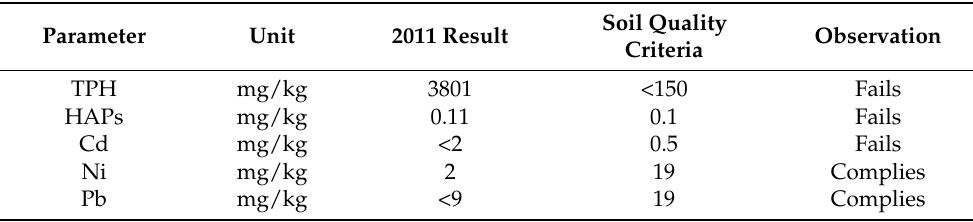
Table 8. Results of the physical-chemical analysis of the Tiputini area. The first results are from EIA and PMA (code B1) and soil quality criteria are from AM097 -A (Table 1) [103], based on the Environmental Impact Study 2011 [104] and Update on the Environmental Impact Study Project Development and Production of the Tiputini and Tambococh Fields